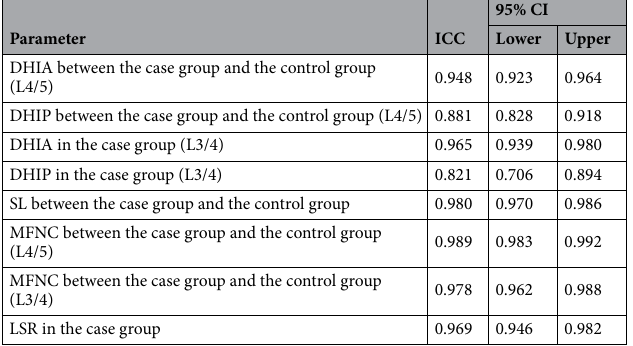
Table 2. ICC test.